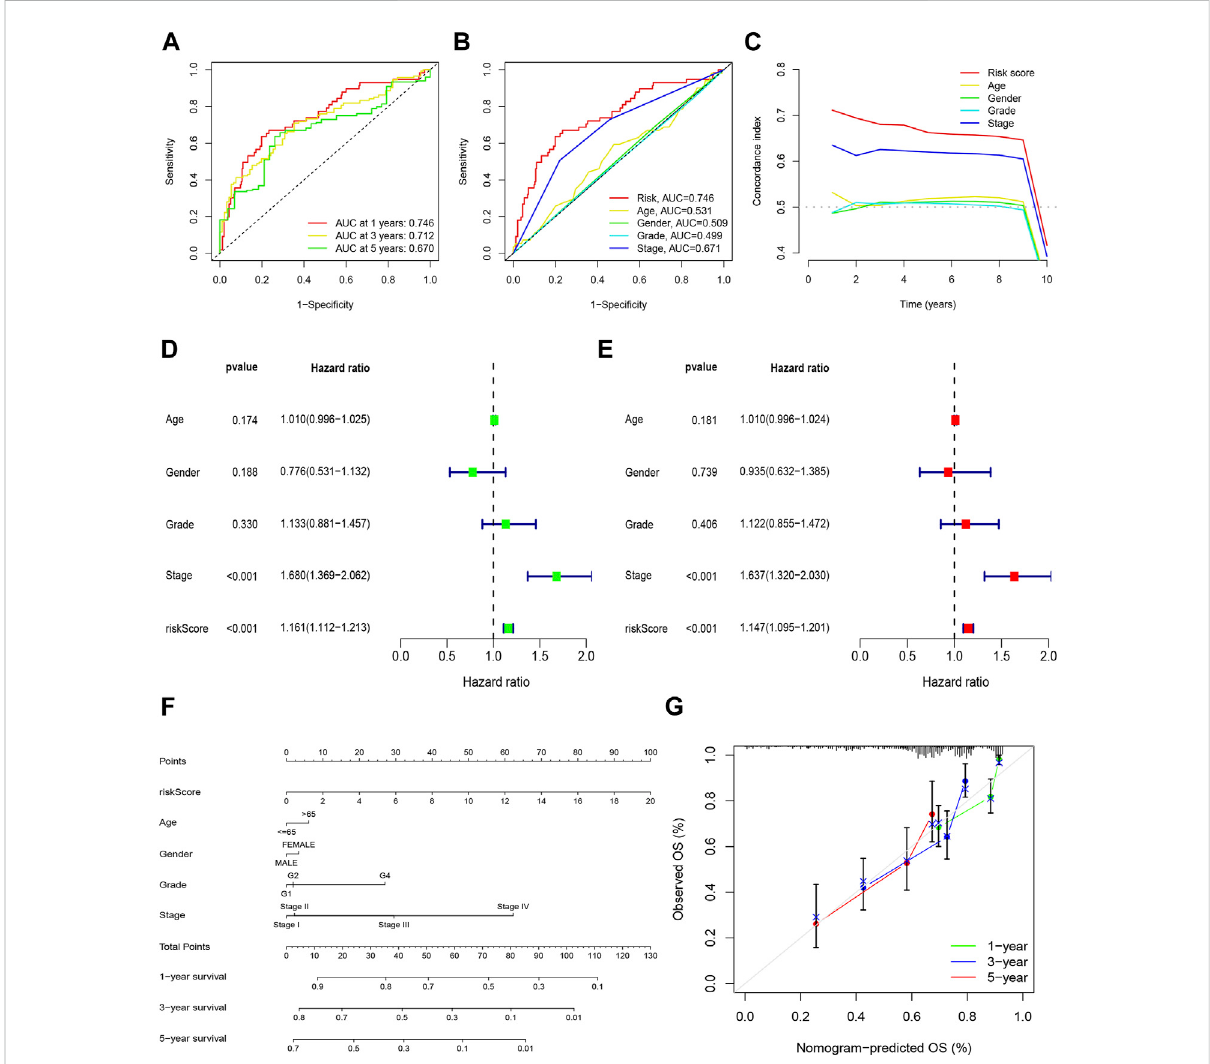
Nomogram and assessment of the risk model. (A) The 1-, 3-, and 5-years ROC curves of the entire sets; (B) The ROC curves of risk score and clinicopathologic features; (C) The C-index curves of risk model; (D) Uni-Cox analyses of clinicopathologic factors and risk score with OS; (E) Multi- Coxanalysesofclinicopathologicfactors and riskscore with OS; (F) Nomogramfor predictingOS; (G) The calibration curves for 1,3,and 5 years